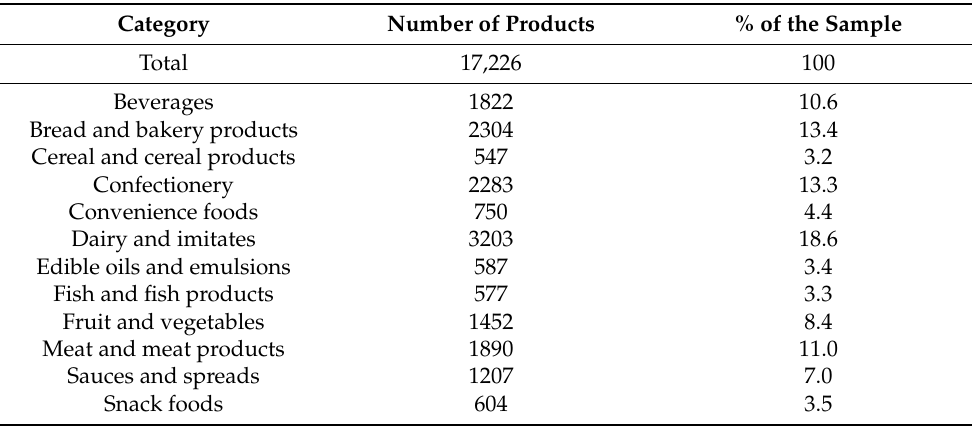
Table 2. Sample description of Slovenian branded food database (2020) used for nutrient profiling with Nutri-Score and Health Star